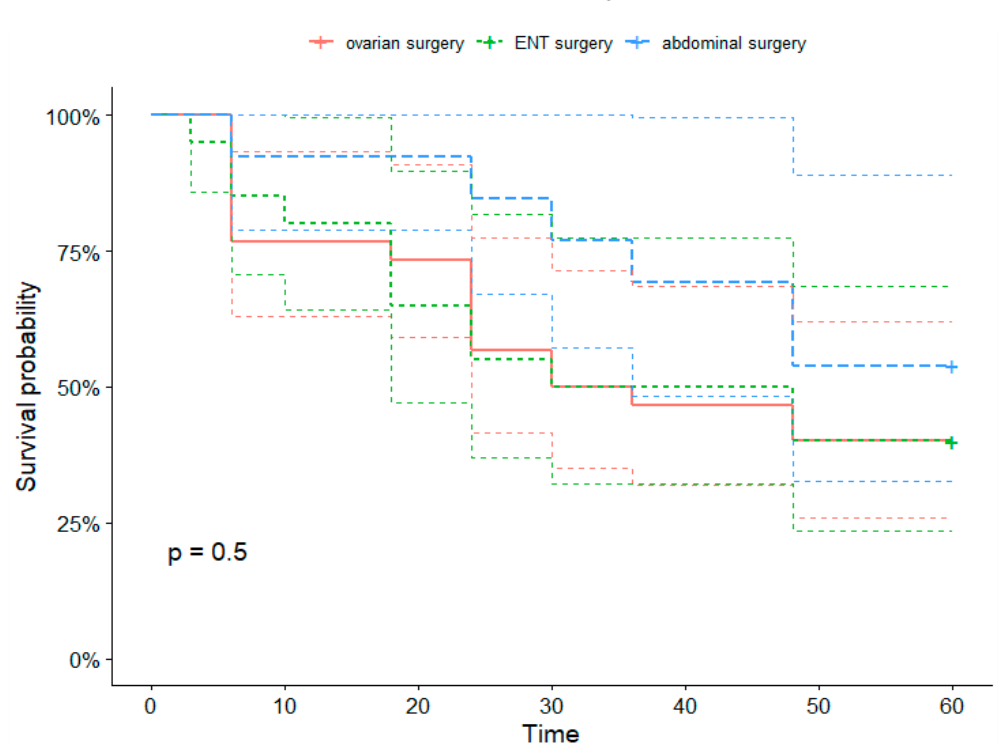
Figure 6. Kaplan–Meier representation of five-year survival according to type of surgery.